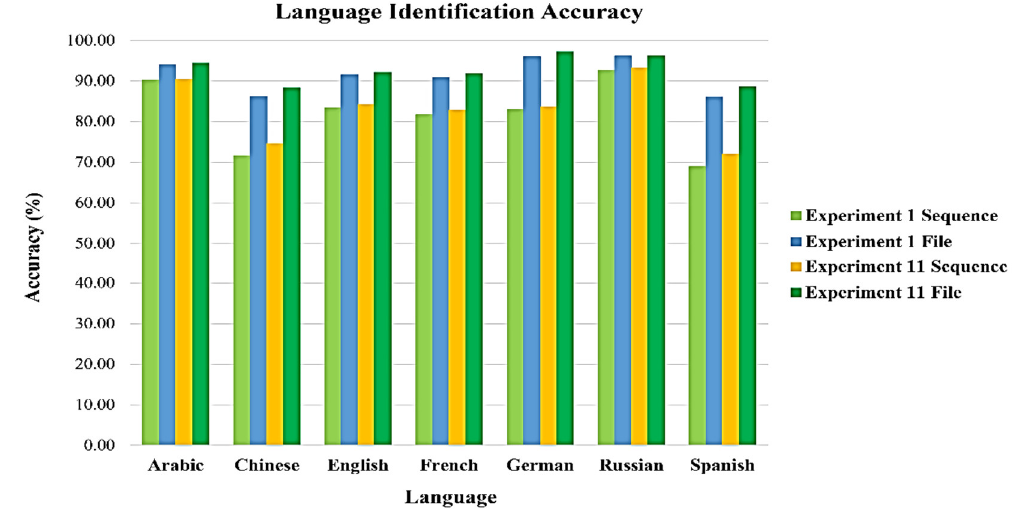
Figure 5. Language identification accuracies. Table 7. The average five-run confusion matrices per file in Experiment 1.